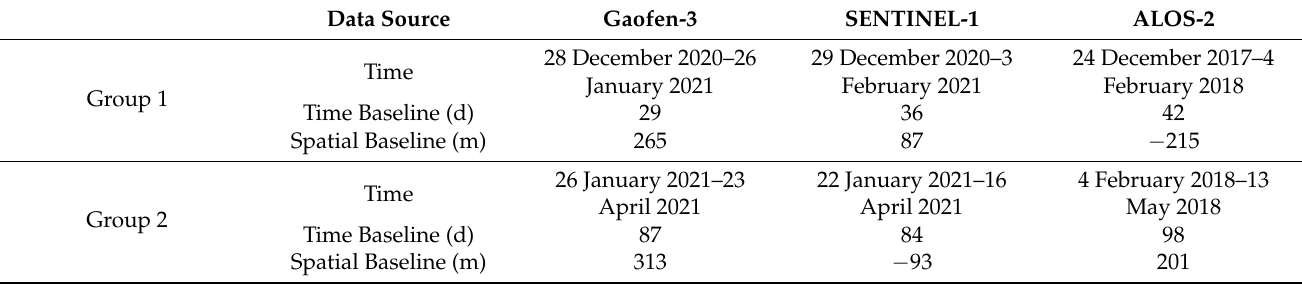
Table 4. Comparison of interference pair